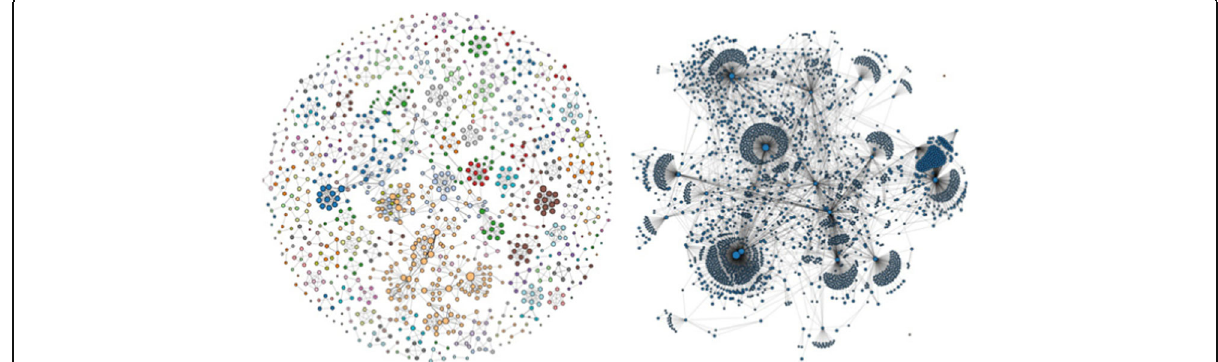
Fig. 2 Left: Force-directed node-link diagram of a co-authorship dataset with 1053 nodes and 3504 edges; Right: Force-directed node-link diagram of the CPAN distribution dataset with 2724 nodes and 7669 edges